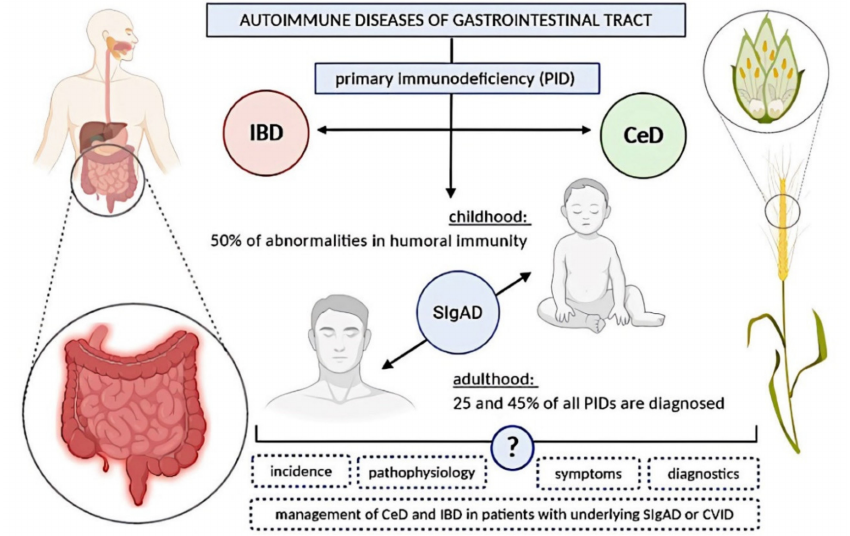
Figure 1. Inflammatory bowel disease and celiac disease as the most common immune-mediated gastrointestinal disorders worldwide and their association with primary immunodeficiencies. IBD, inflammatory bowel disease; CeD, celiac disease; SIgAD, selective IgA deficiency; CVID, common variable